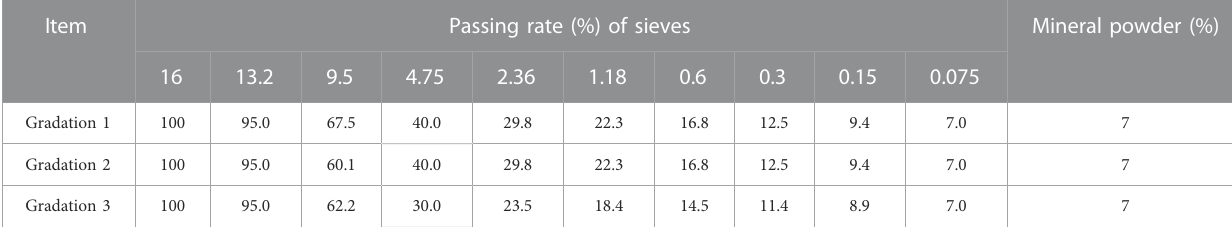
TABLE 12 Passing rates of the three gradation types. Item Passing rate (%) of sieves